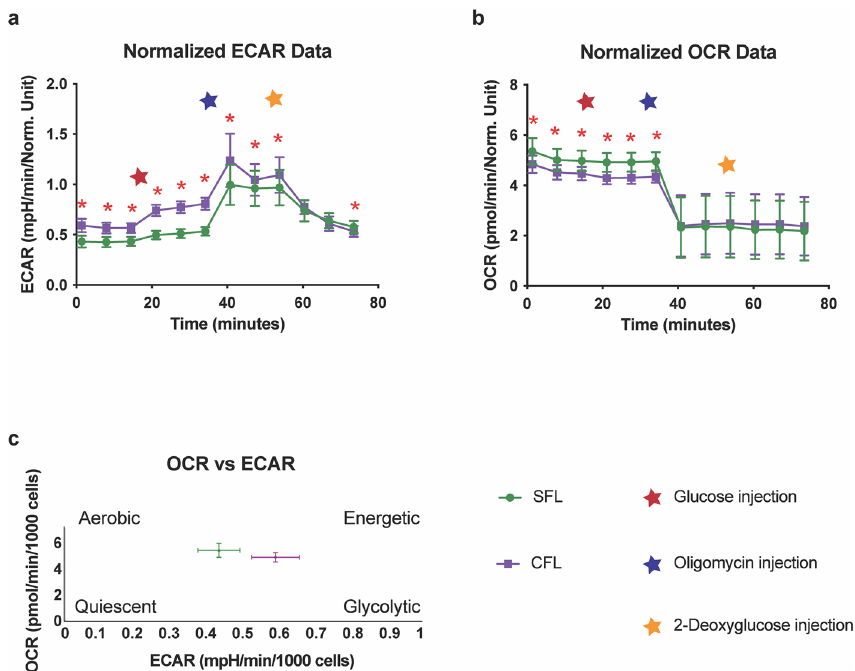
Figure 3. The figure shows results from the Seahorse assay. ( a ) Extracellular acidification rate (ECAR) for SFL and CFL. ( b ) Oxygen consumption rate (OCR) for SFL and CFL. ( c ) OCR vs ECAR graph reflecting increased glycolysis for CFL. * indicates p-value < 0.001 as calculated using a two-tailed Student’s t